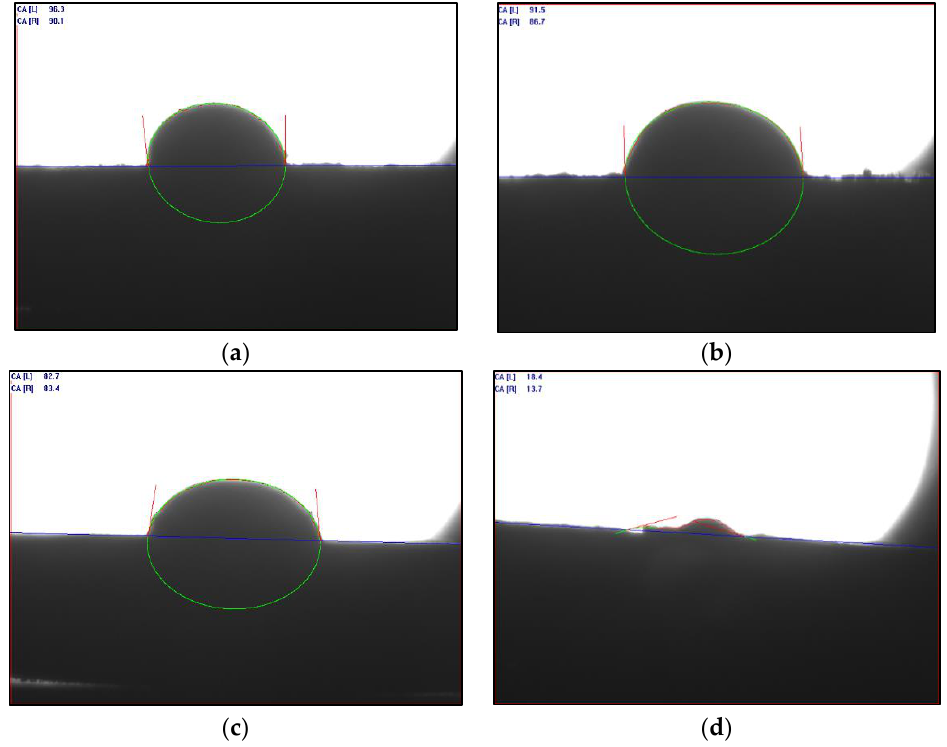
Table 6. The wetting angle of Ag and SnO 2 under different conditions.